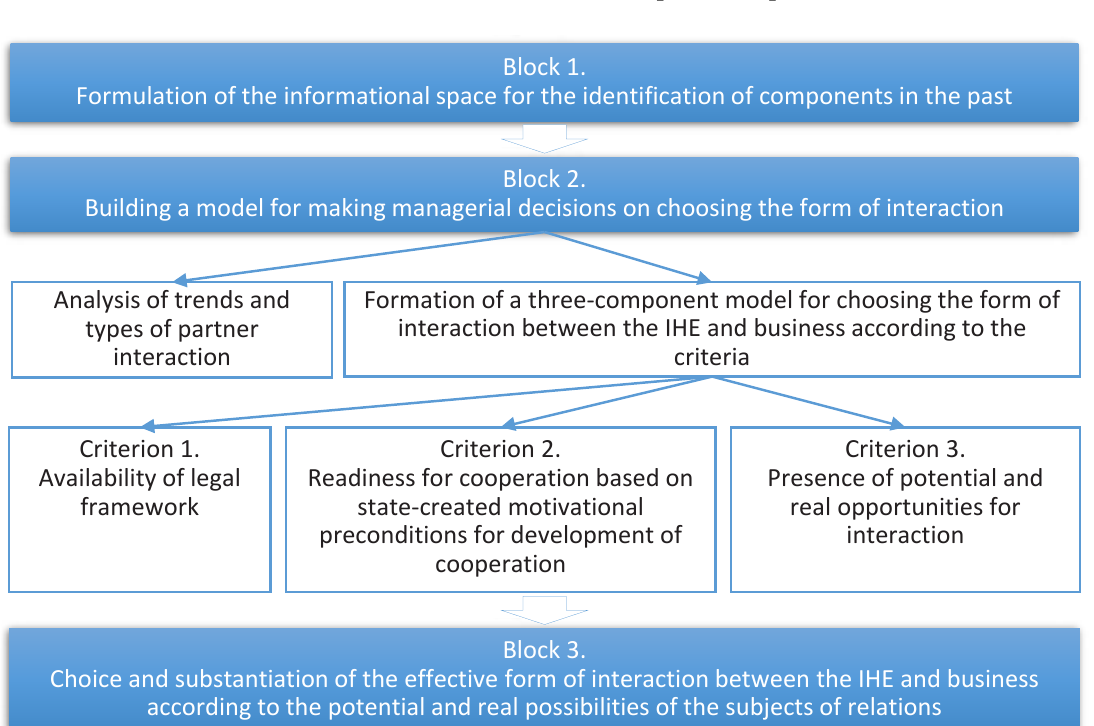
Figure 2. Methodological approach to the formation of interaction and adaptive use of appropriate forms of cooperation IHE and business